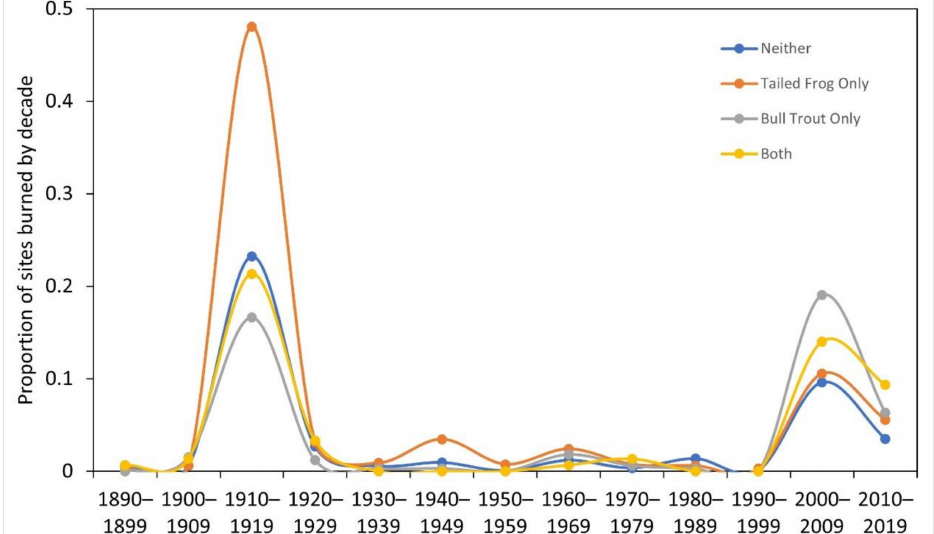
Figure 7. Proportion of sites with recorded wildfire in the watershed each decade, from 1890 to 2019, categorized by recent (2006–2011) occupancy combinations of tailed frogs and bull trout from 2829 electrofishing surveys. Fire events from 1878 and 1889 were excluded due to a single year of fire data present in each of the respective